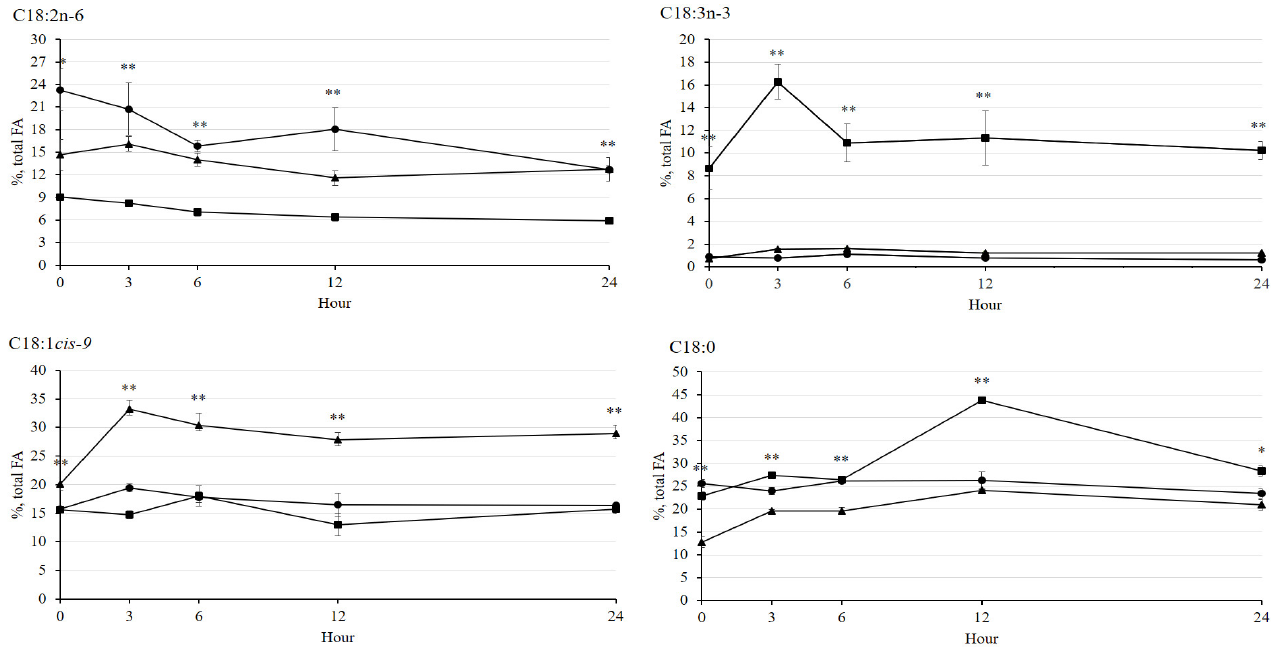
Figure 4. Changes in major 18-carbon fatty acid concentrations (%, FA) during rumen incubation with oil sources containing essential fatty acid for 24 h of incubation. Diet with corn oil, C18:2n-6